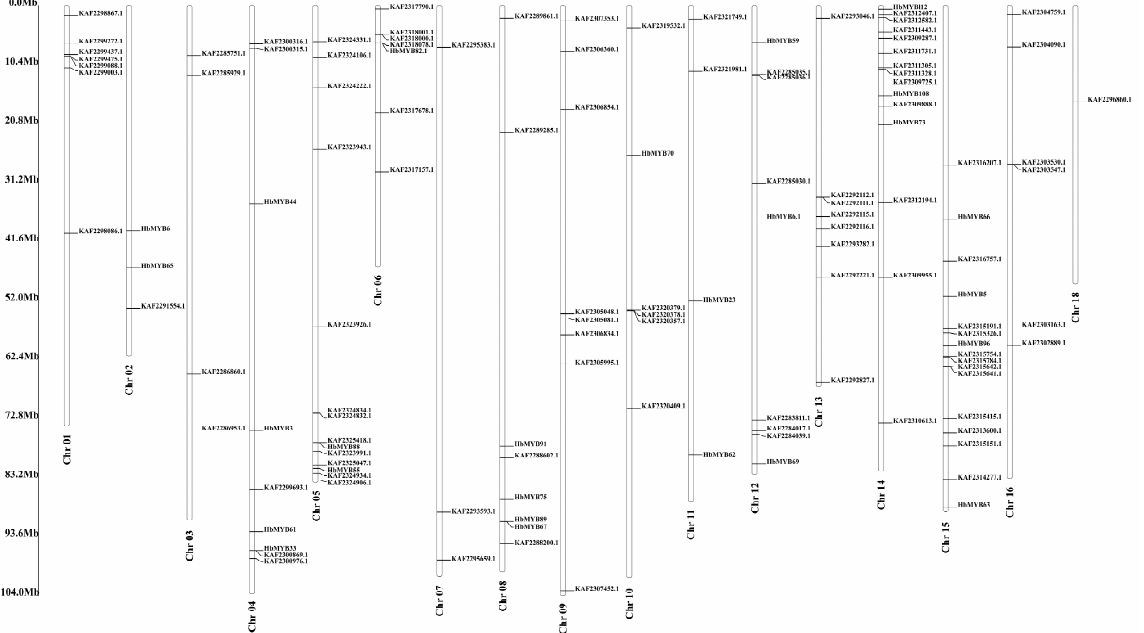
Figure 1. Chromosomal location of HbMYBs .